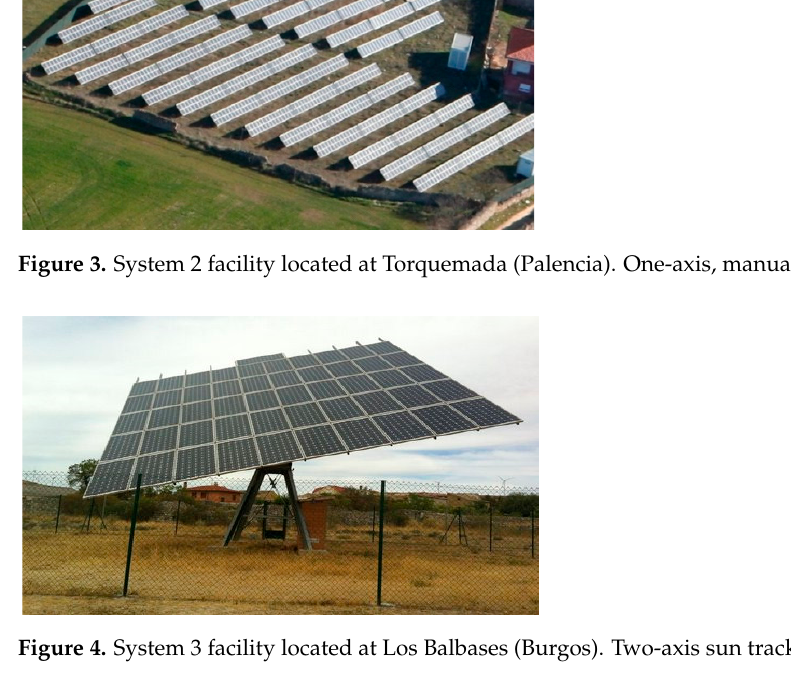
Figure 2. System 1 facility located in the city of Palencia. Fixed roof panels.